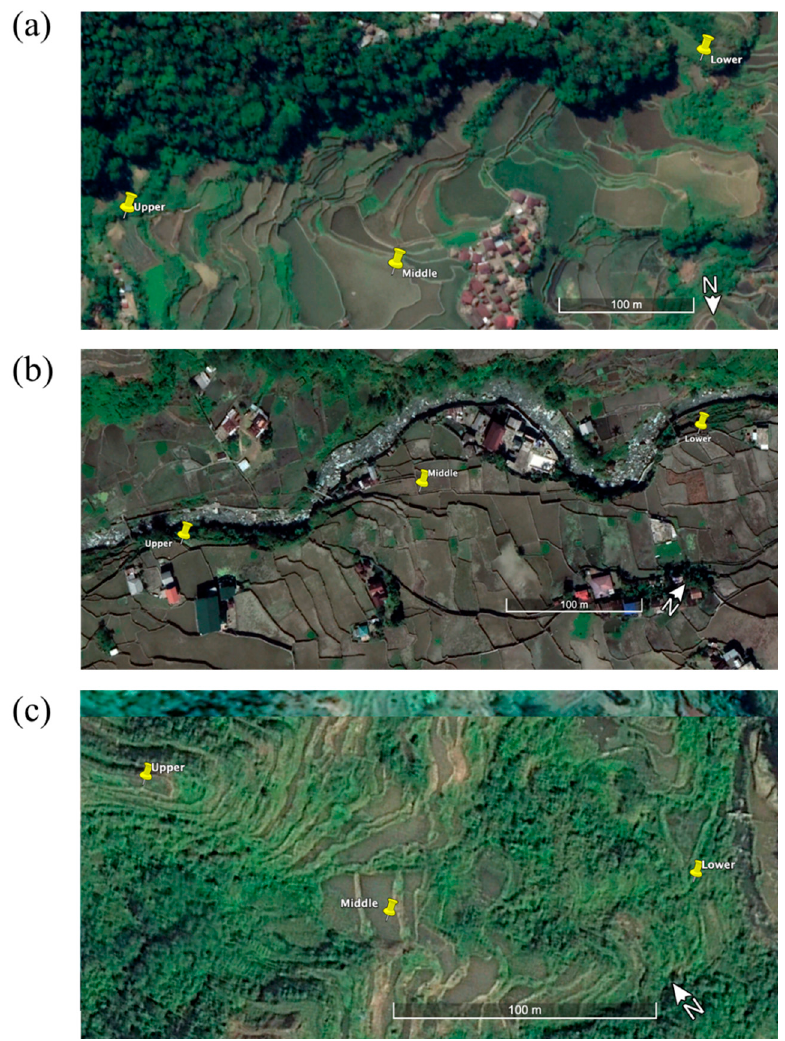
Figure 2. Sampling location ( a ) Bangaan, ( b ) Hapao, and ( c ) Poblacion (cited from Google Earth Pro ver. 7.3.3.7669).